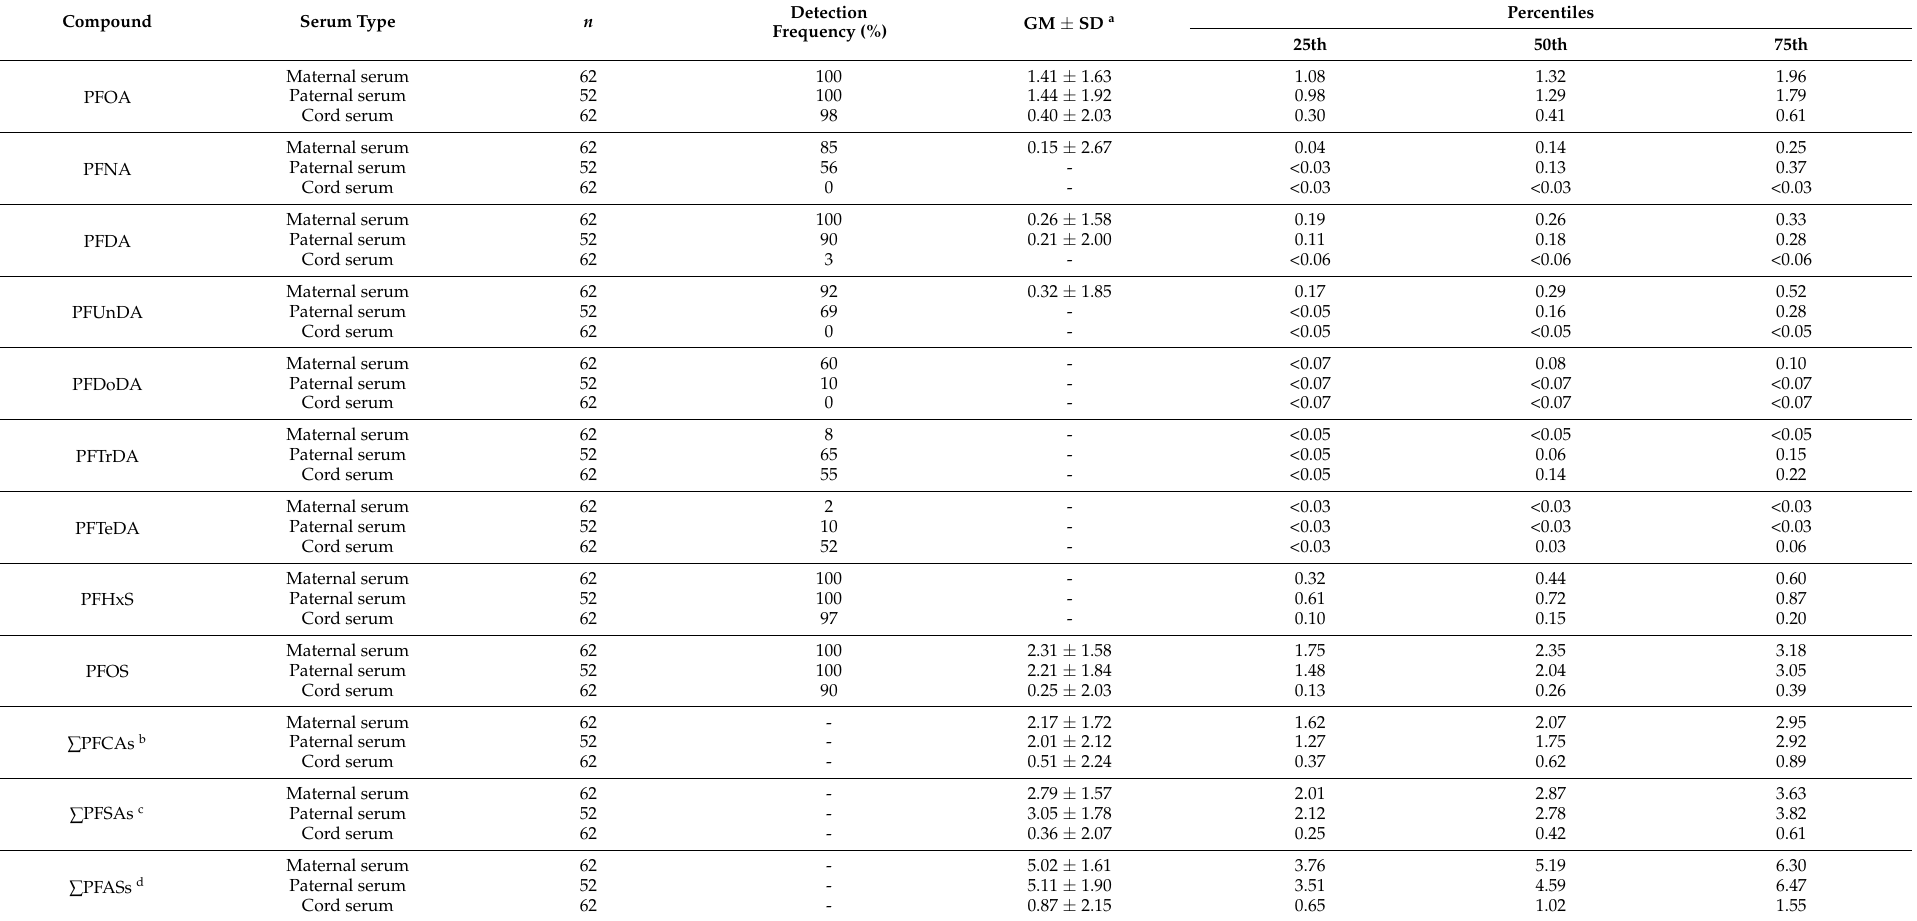
Table 2. Detection frequencies and concentrations (ng/mL) of perfluoroalkyl substances (PFASs) in maternal, paternal, and cord